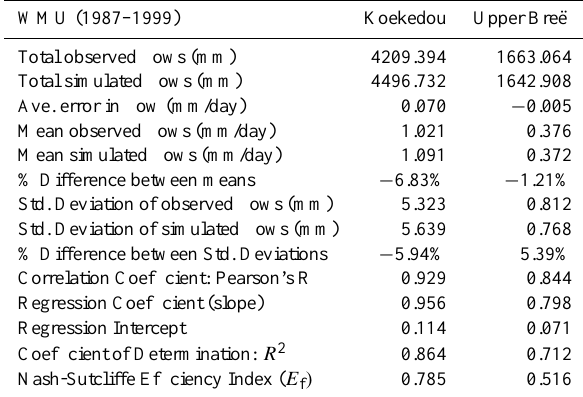
Table 7. Statistics of performance of the ACRU model Luvuvhu Catchment: comparison of Daily Observed and Simulated Values.